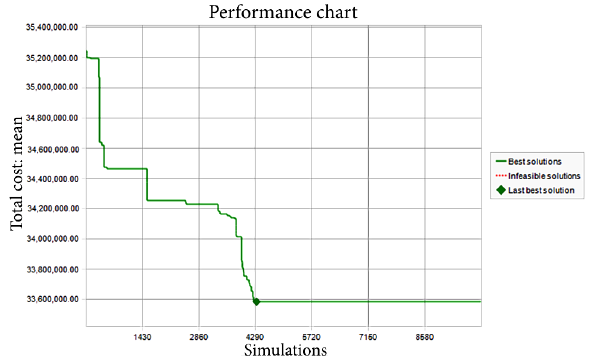
Figure 2. FMCS optimization performance Table 4. Selected materials percent for each system